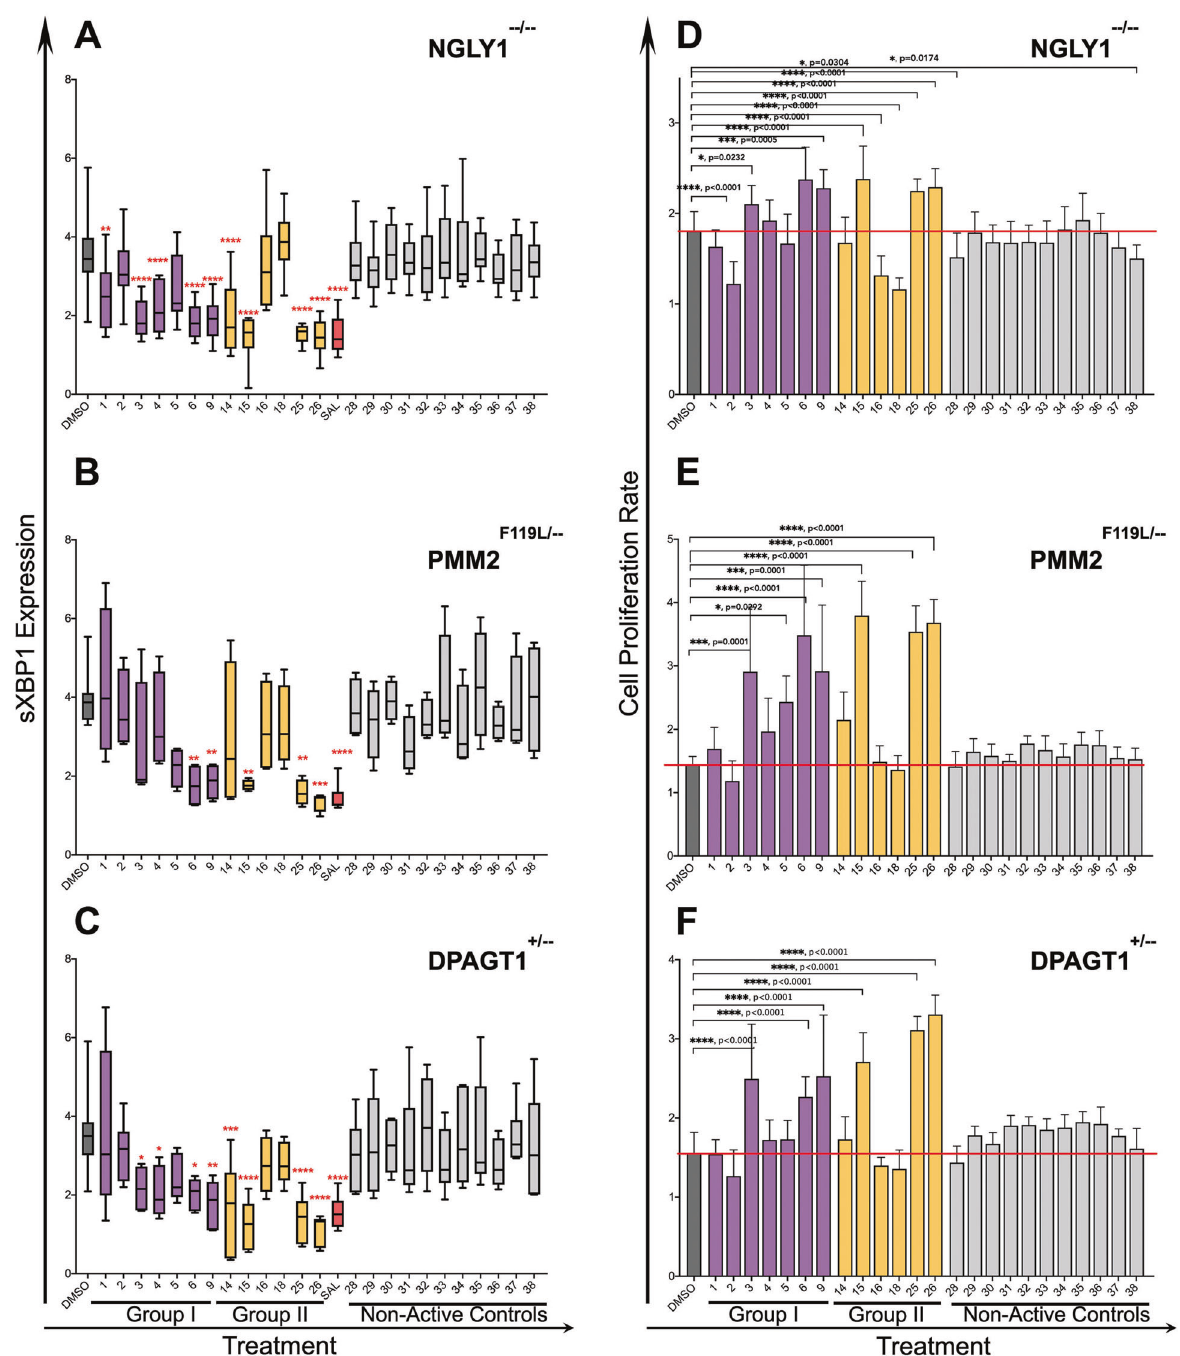
Fig. 6 Validation that active compounds correct proliferation defects and an ER stress phenotype shared across the CDG and CDDG lines. CDG and CDDG cell lines were treated with optimized concentrations of candidate and non-active control compounds and expression of s XBP1 and cell proliferation were assessed. A – C Expression levels of s XBP1 in NGLY1 − / − ( A ), PMM2 F119L/ − ( B ), and DPAGT1 + / − ( C ) clones treated with candidates or non-active compounds. Results are presented as a ratio of s XBP1 levels in compound-treated cells to vehicle treated cells ( n ≥ 10 per each genotype or treatment). D – F Modulation of proliferation rate of NGLY1 − / − ( D ), PMM2 F119L/ − ( E ), and DPAGT1 + / − ( F ) lines treated with candidates or non-active compounds ( n ≥ 10 per each genotype or treatment). To de fi ne cell proliferation rate, ratio of OD 590 at 72 h to OD 590 at 24 h post seeding (before treatment) was calculated. Data presented are an average for all clones available for a speci fi c mutation. ** P < 0.01, *** P < 0.001, **** P < 0.0001, one-way ANOVA followed by Dunnett multiple comparisons